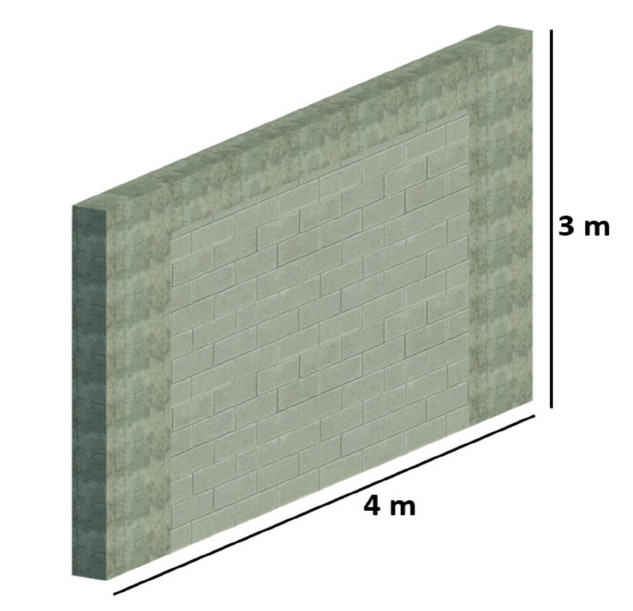
Figure 2. Conventional construction method